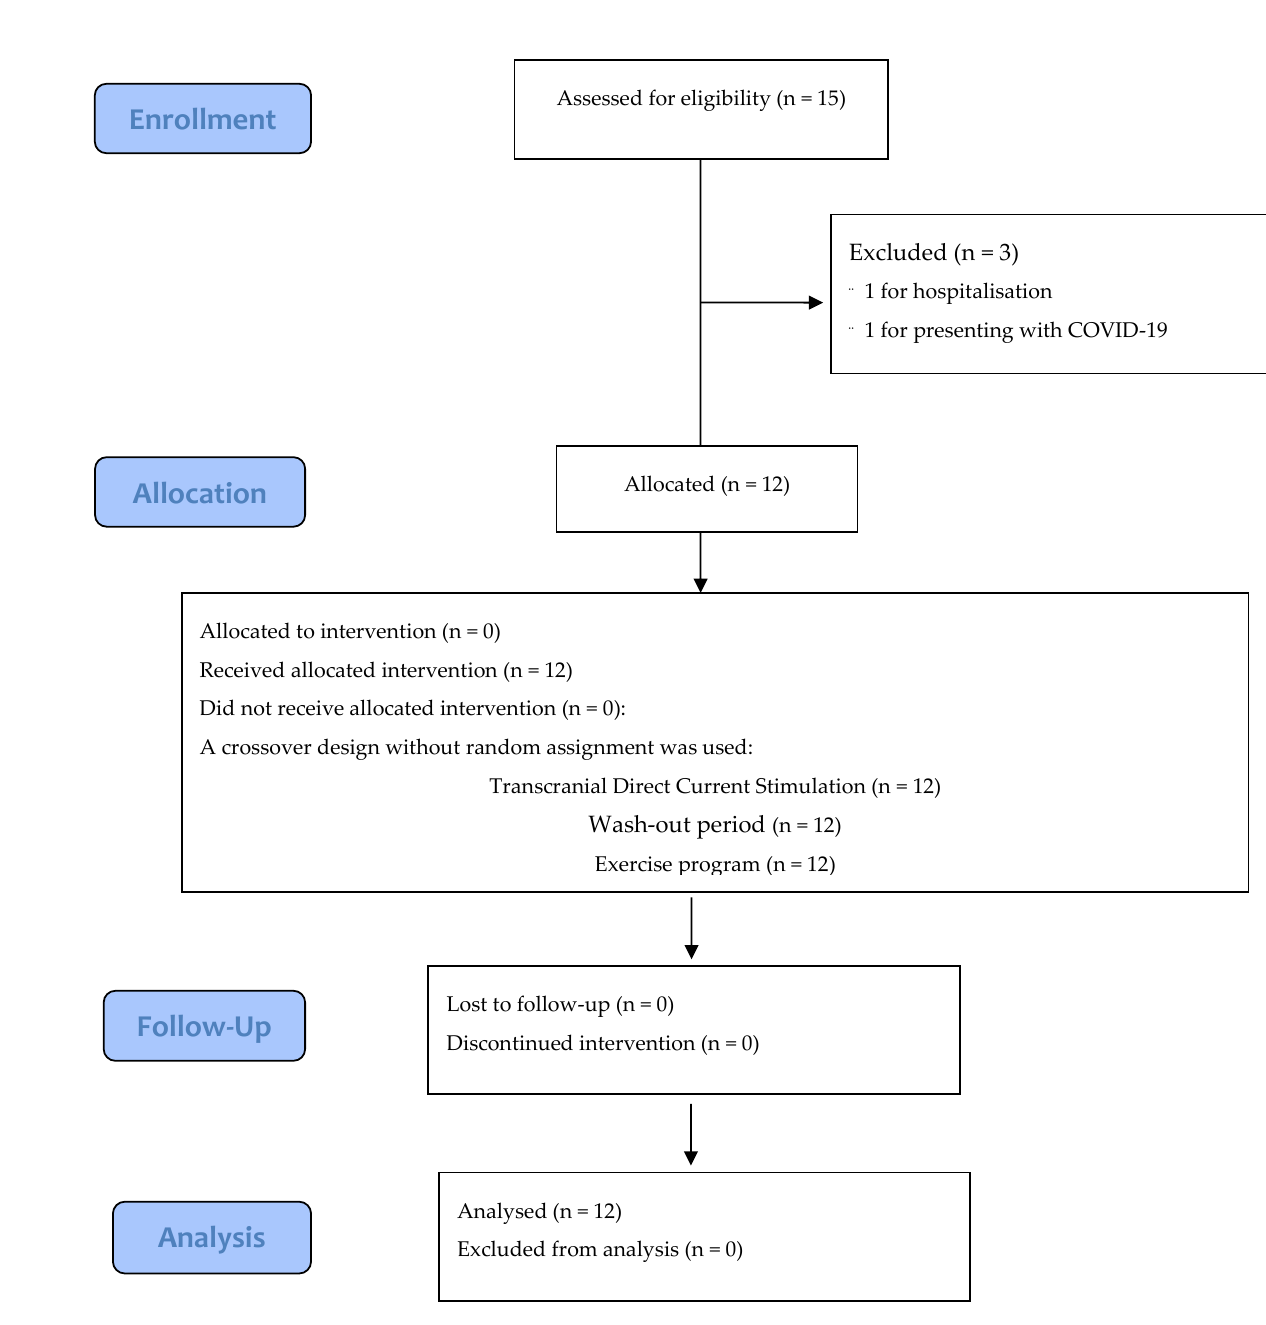
Figure 1. CONSORT flow diagram of this study.